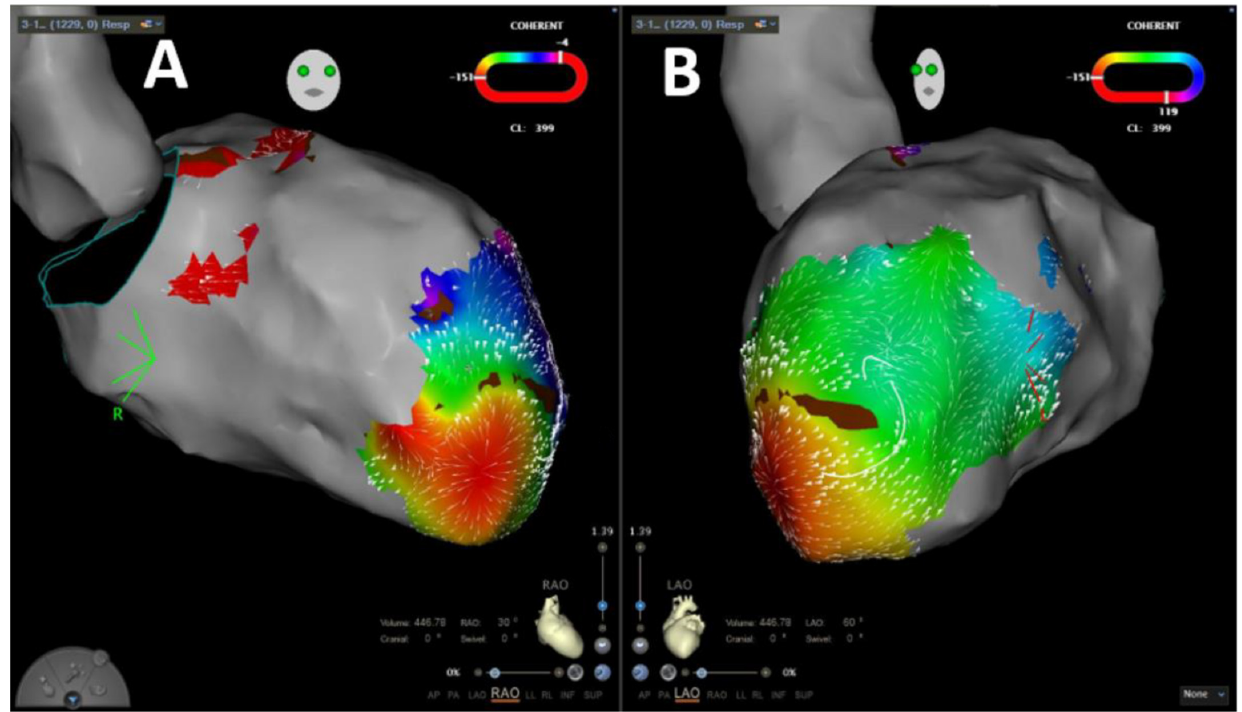
Figure 2. Representative image of velocity-vector-based coherent mapping for ventricular arrhythmia propagation mapping in RAO ( A ) and LA ( B ) projections.